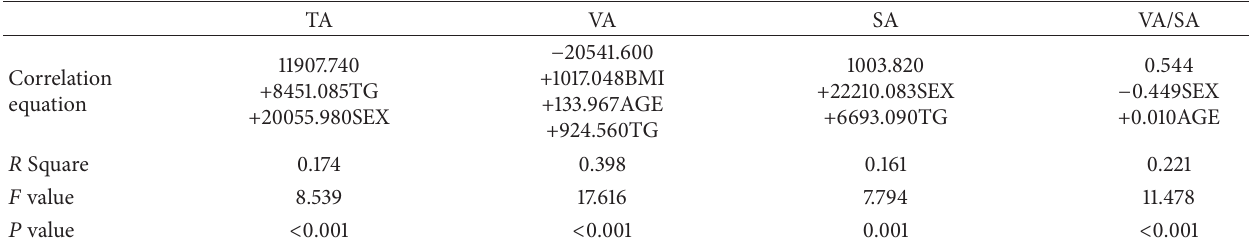
Table 3: Correlation of abdominal fat in subjects with type 2